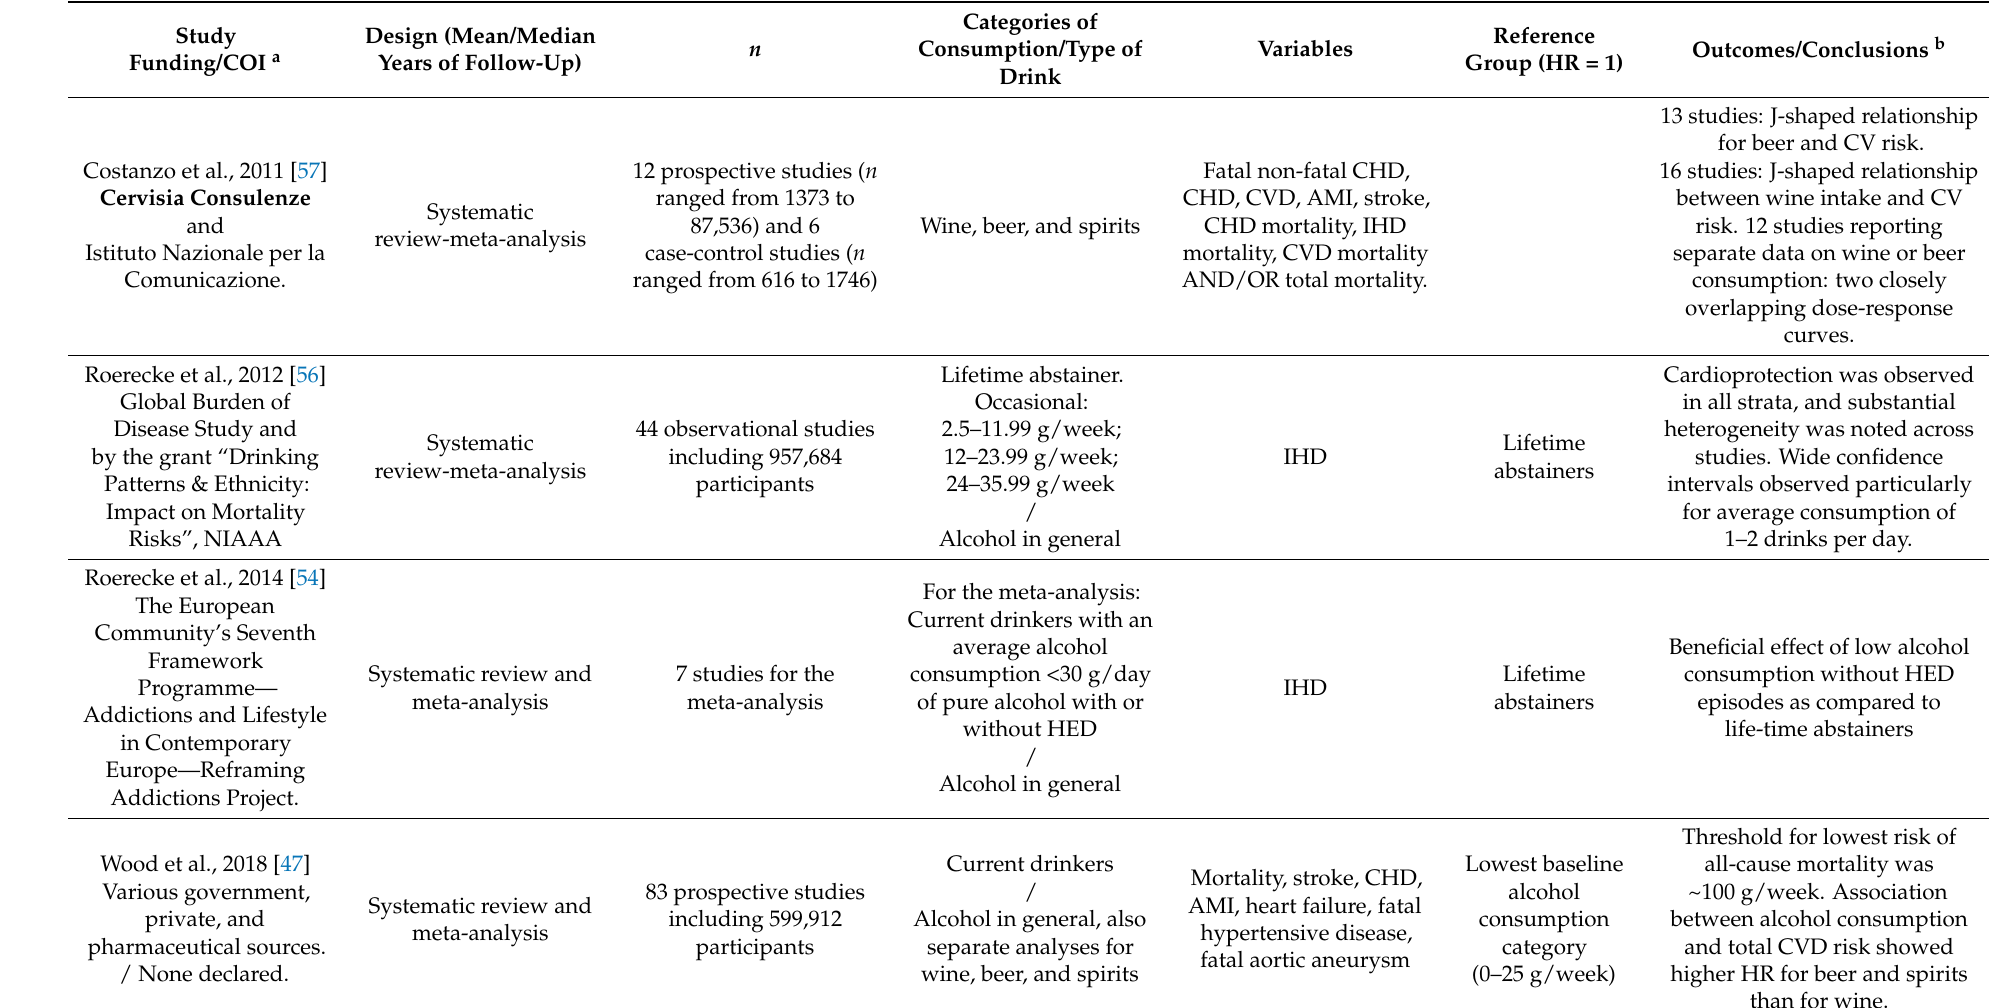
Table 4. Summary of the main cardiovascular (CV)